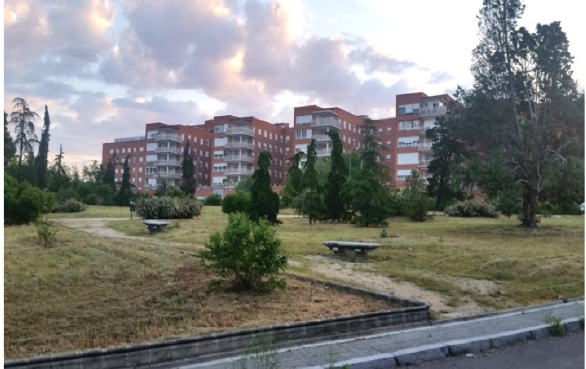
Figure 1. Rafael Sánchez Arcas 1933-1936, Hospital Clínico